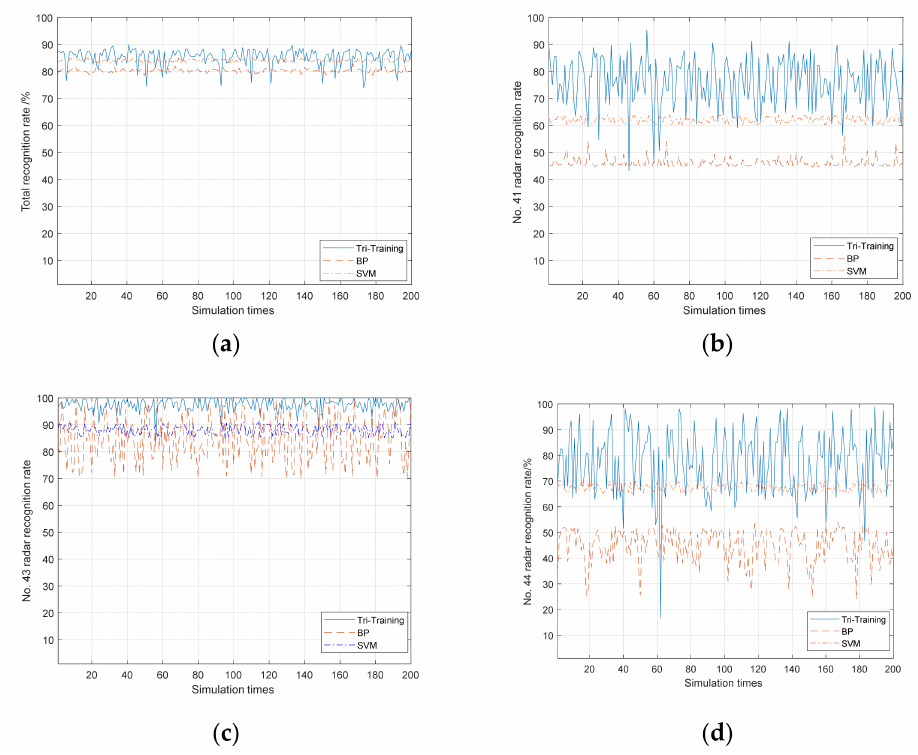
Figure 8. Monte Carlo simulation results. ( a ) Total recognition accuracy; ( b ) Radar 2 recognition results; ( c ) Radar 3 recognition results; and ( d ) Radar 4 recognition